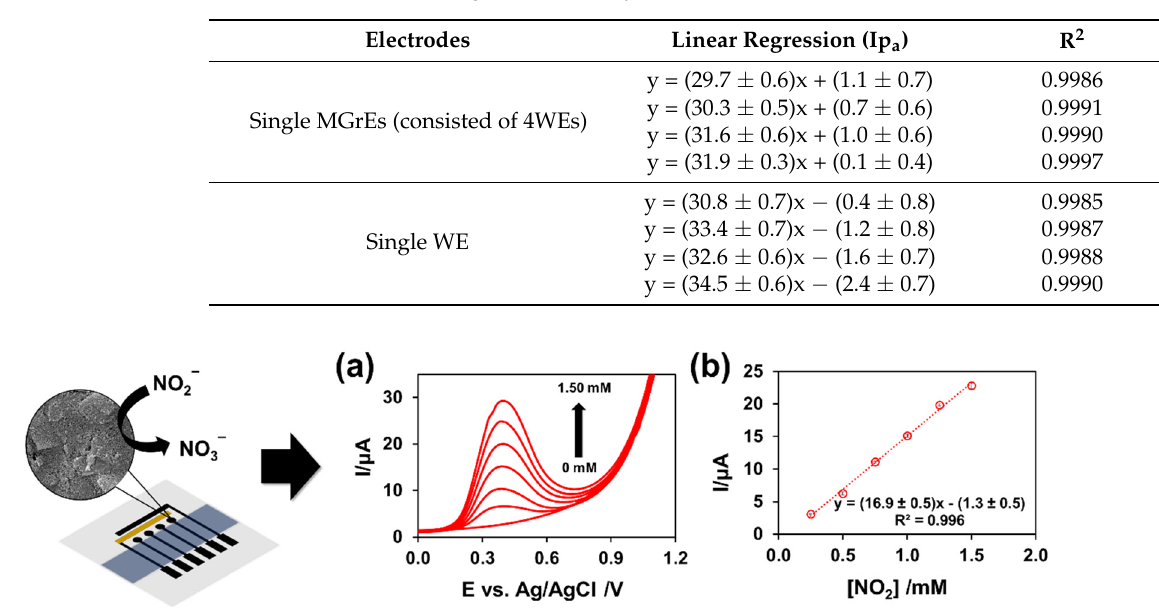
Table 1. The linear regression of anodic peak current of nitrite (0.25–2.00 mM) obtained from four WE of an MGrEs and a single WE tested by CV.